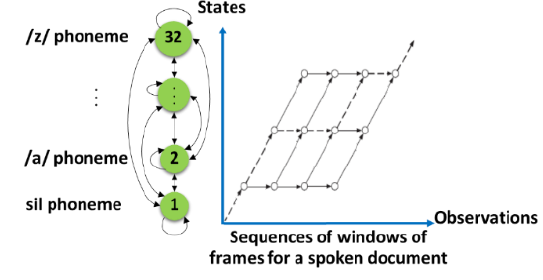
Figure 3. Performing Viterbi algorithm on HMM to find optimal phoneme sequence for a spoken document.